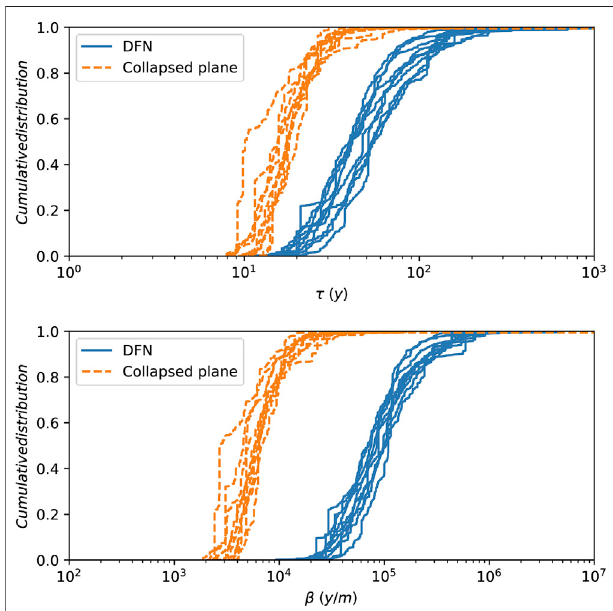
FIGURE 3 | Cumulative distribution of τ and β of the trajectories of all DFN realizations.